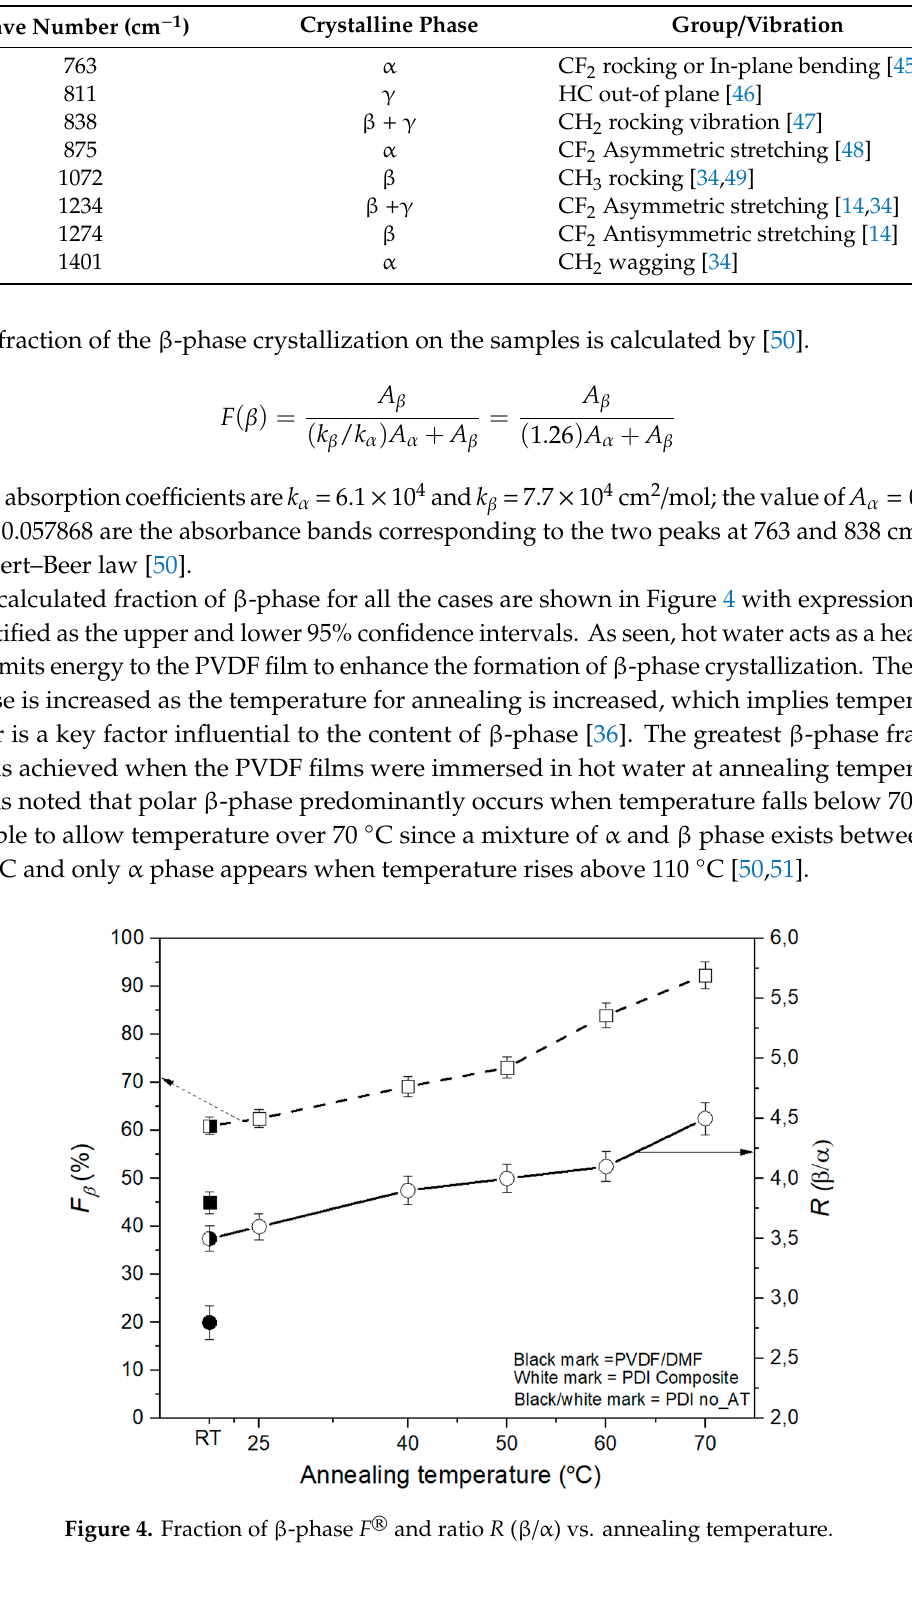
Table 1. FTIR analysis of PVDF / N, N-dimethylformamide (DMF) + IL (PDI) composite film.